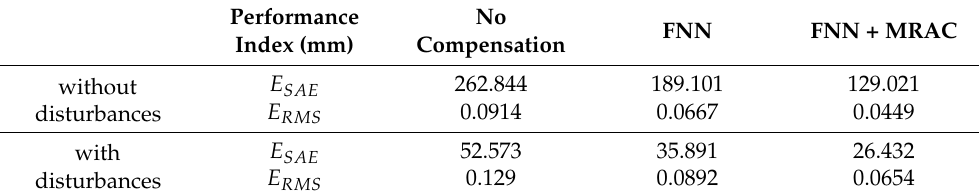
Table 5. Synchronous performance under high-frequency